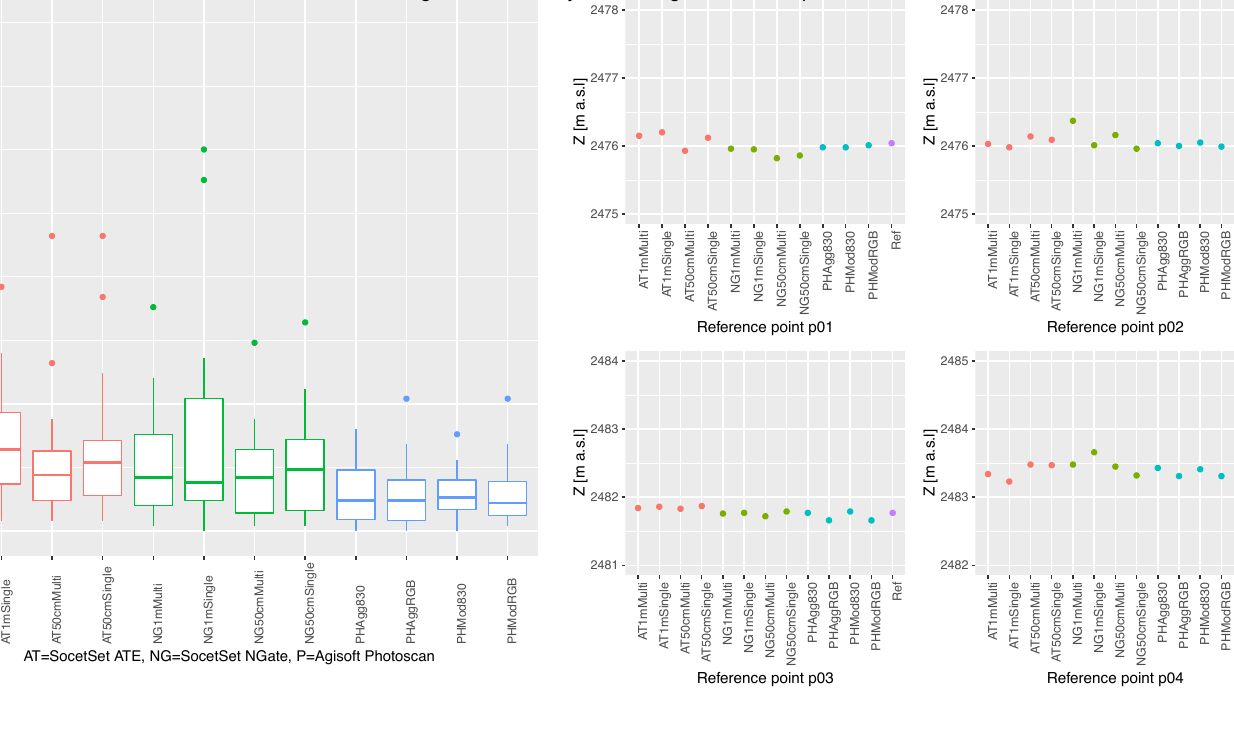
Figure 6. Reference point 1-4 (reference height at the far right)